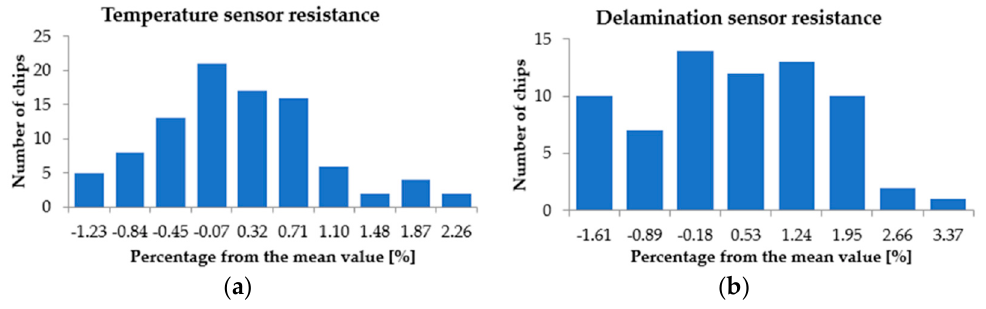
Figure 12. R 0 spread for: ( a ) The temperature sensor; ( b ) The delamination sensor.